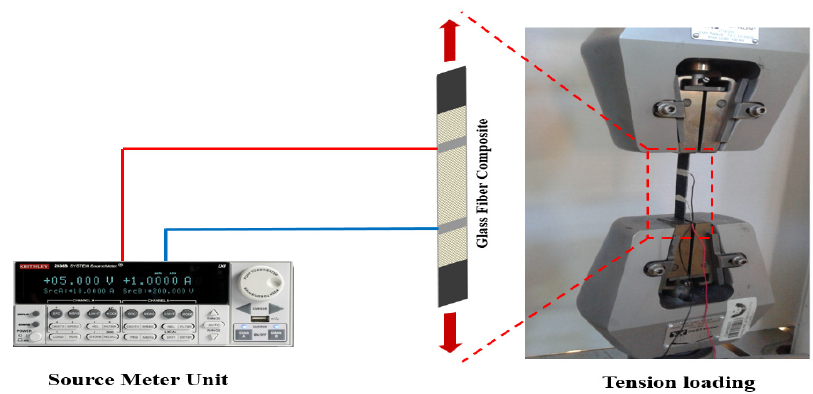
Figure 5. Schematic of electrical resistance measurement of glass fiber composite coupons during tension tests.